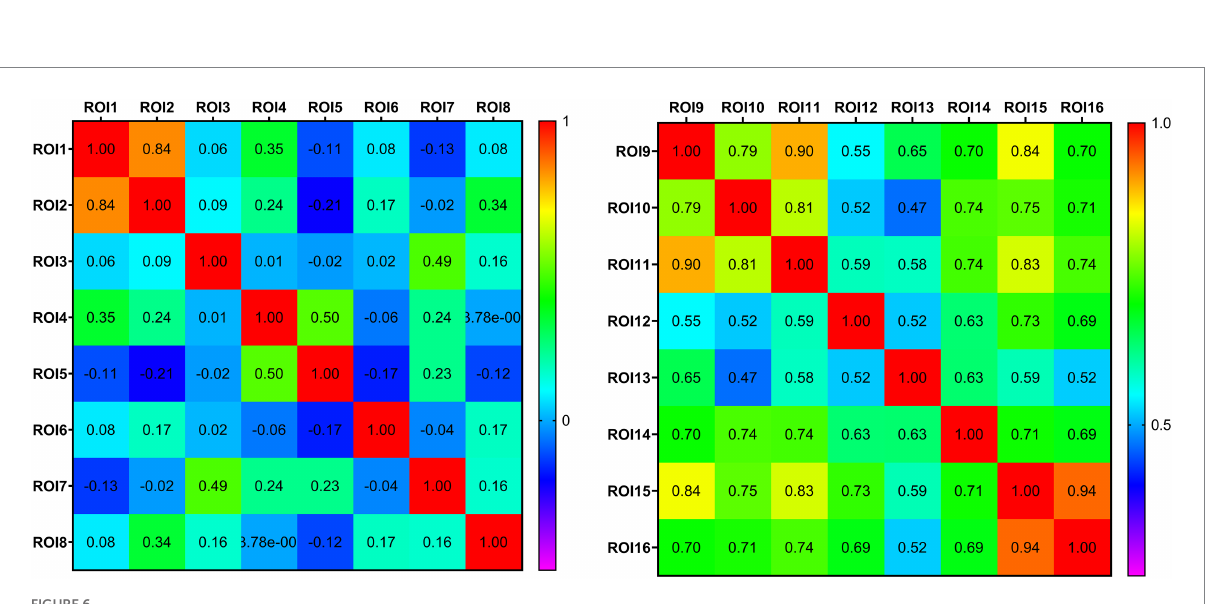
FIGURE 6 Thermodynamic diagram of the connectivity matrix of region of interest. Each row and column in the matrix corresponds to different region of interest. The value at the intersection of the rows and columns represents the correlation coefficient of the functional connection of the corresponding brain regions. Positive values represent a positive correlation and negative values represent a negative correlation. The larger the value, the closer the functional